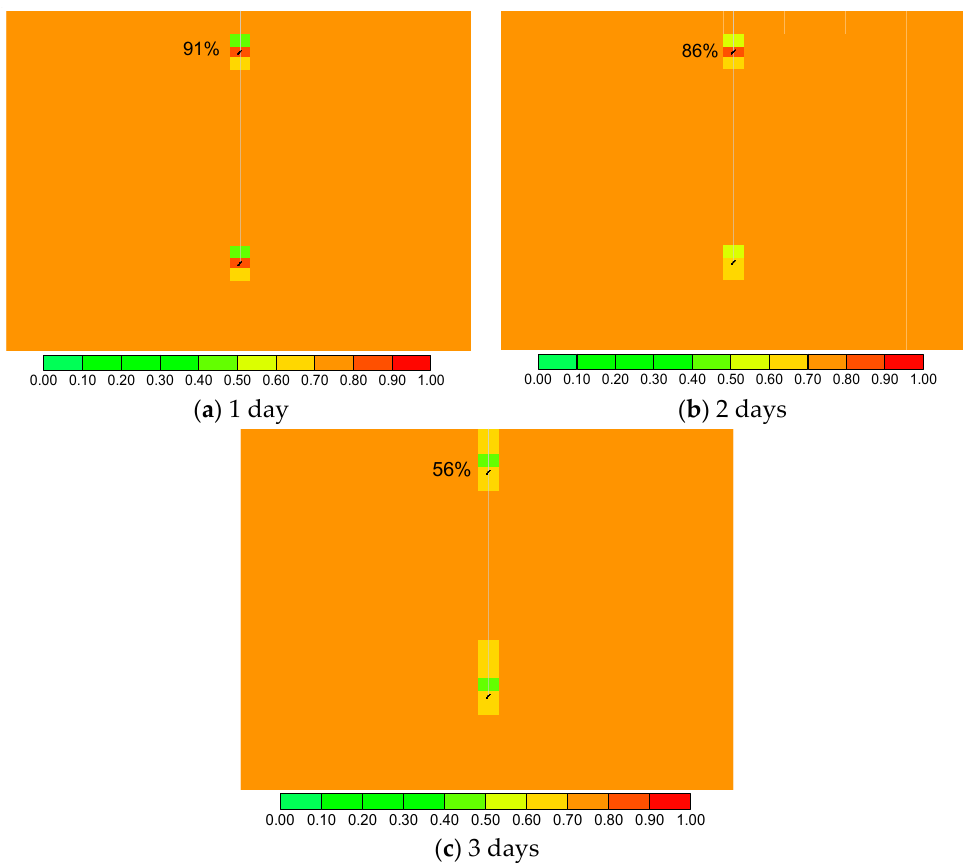
Figure 8. Oil saturation profile after fluid replacement for different periods (Color bar: Oil saturation, %. ( a , b , c ) subfigure means fluid replacement for 1 day, 2 days, 3 days, respectively).